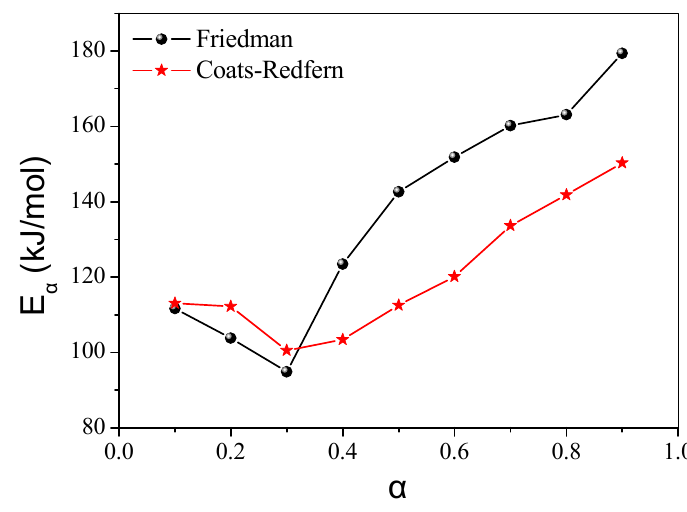
Figure 7. Correlation plots of effective activation energy versus the extent of degradation for PMMA + 1 wt % Cloisite 15A, determined using different methods.